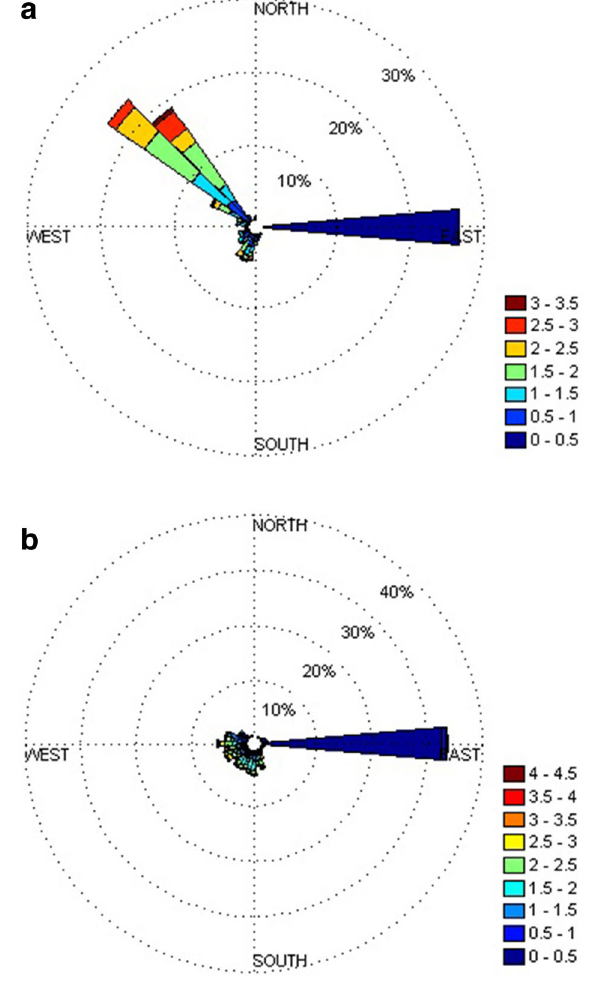
Fig. 3 Wind distribution during artificial aeration, the unit of wind speed is m s - 1 . a Wind distribution during 30 July–1 August, b